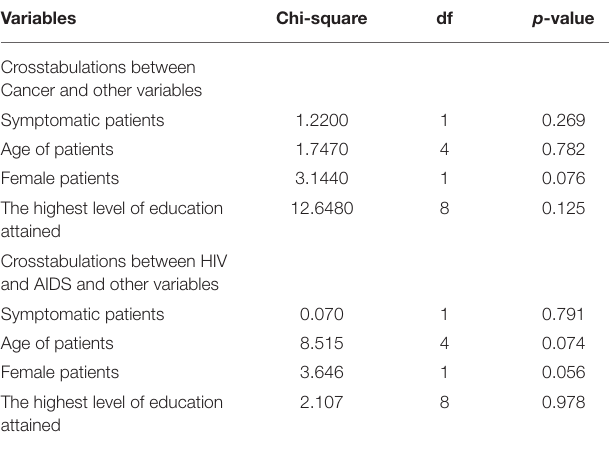
Variables Chi-square Crosstabulations between Cancer and other